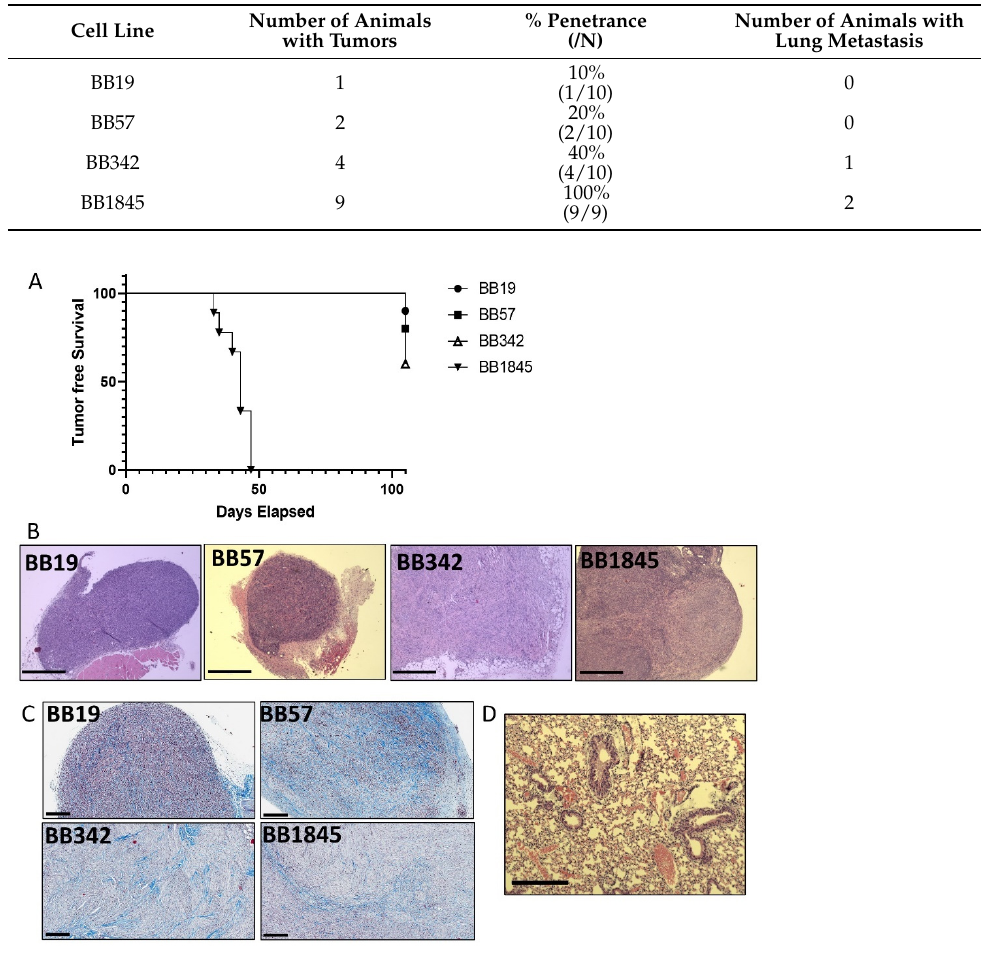
Figure 5. Cell lines develop syngeneic subcutaneous tumors. ( A ) Kaplan Meyer plot of tumor free survival of animals subcutaneously injected with Braf-driven tumor cell lines. (Note only 4 cell lines were on congenic 129SvJ background and therefore able to be syngeneically injected into WT 129SvJ recipients.) ( B ) Representative H&E and images of subcutaneous tumors. Black scale bars are 750 µM.( C ) Representative Trichrome images of subcutaneous tumors. Collagen is blue, nuclei are black, and muscle tissue erythrocytes and cytoplasm are red to pink. Black scale bar is 200 µM. ( D ) Representative H&E image of a lung metastasis. Black scale bar is 300 µM.